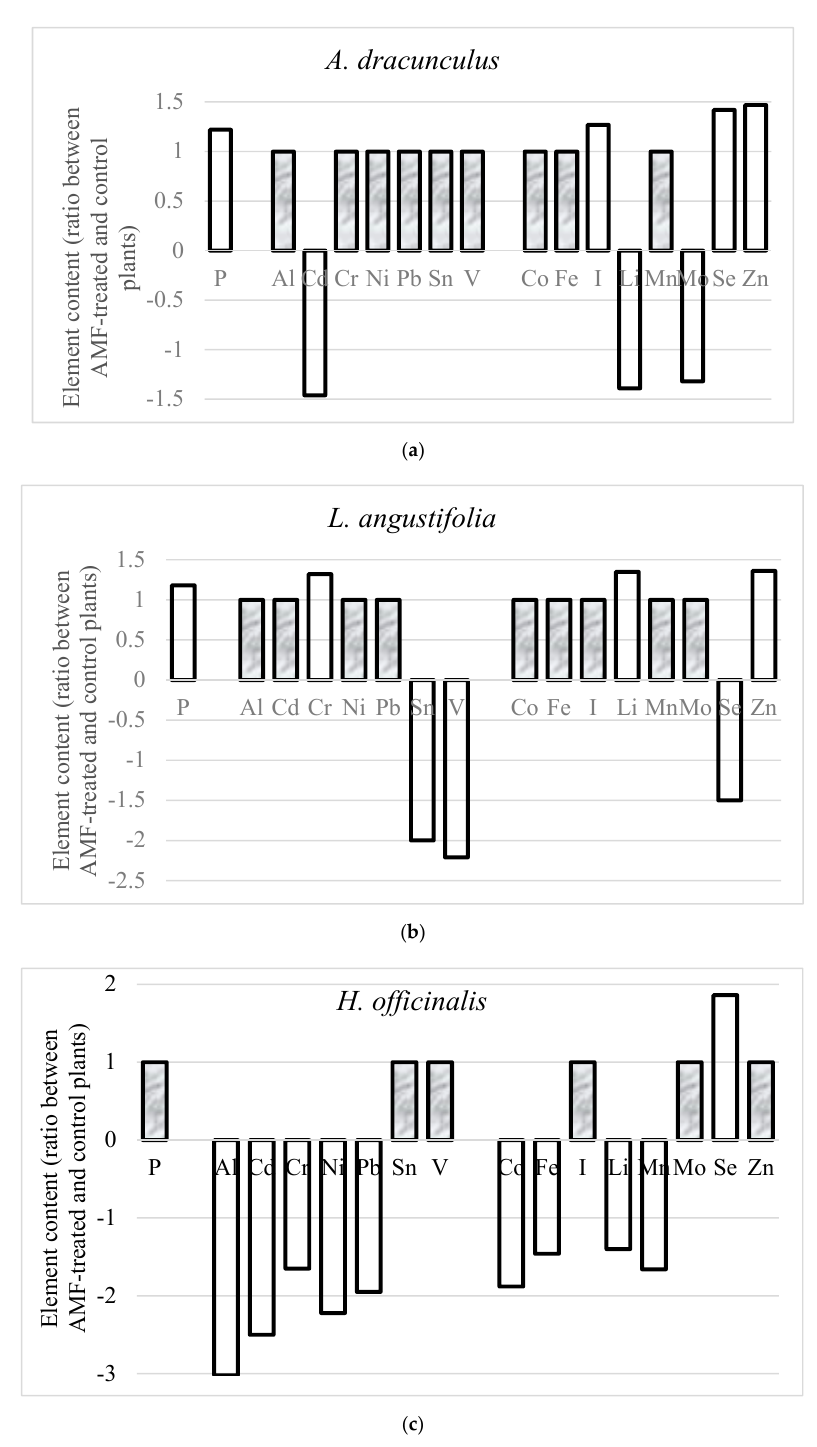
Figure 4. Differences in macro-element, trace-element and heavy metal content between control and AMF-treated plants of A. dracunculus ( a ), L. angustifolia ( b ) and H. officinalis ( c ) (dark columns indicate non-significant differences).